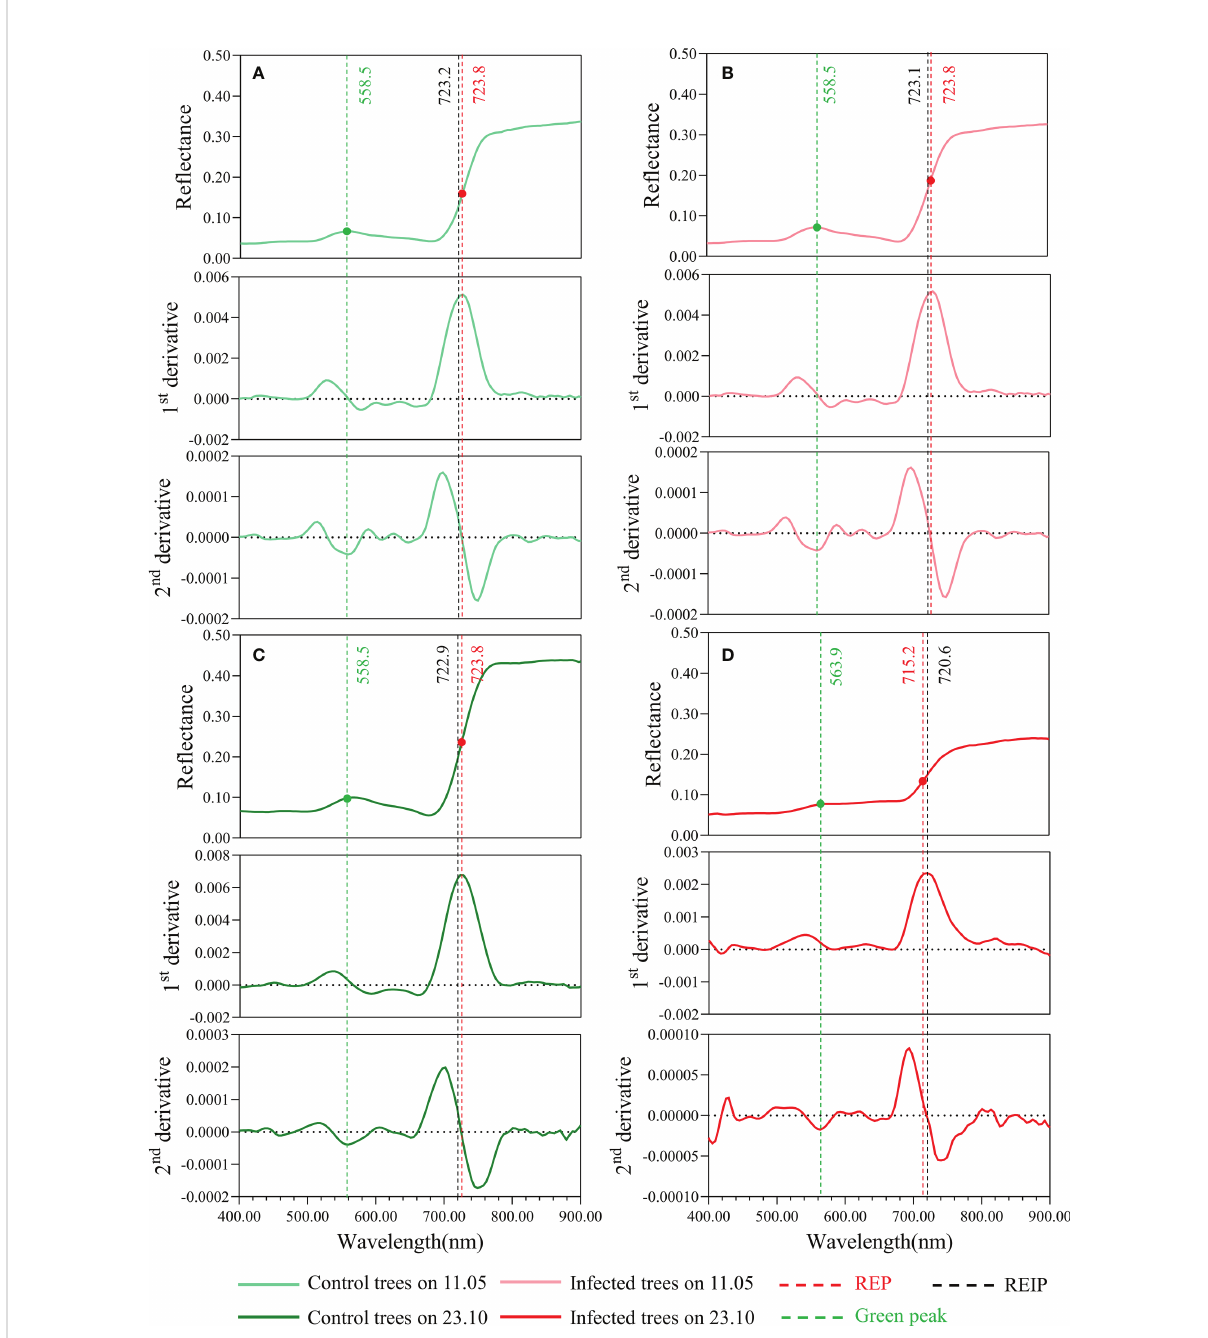
FIGURE 7 Mean tree crown spectra with 1 st and 2 nd derivative of infested trees (right) and control trees (left) on 11.05.2021 (A, B) and 23.10.2021 (C, D) . The green peak (green dots), red edge infestation point (black lines), and red edge position (red dots) are also